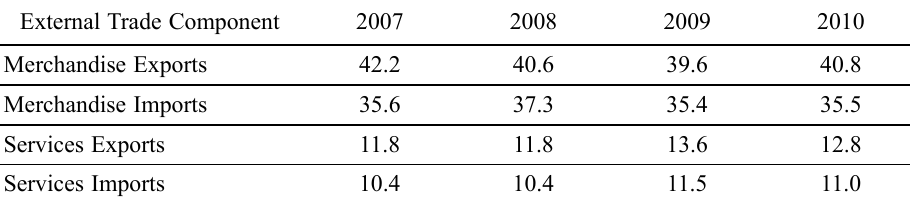
Table 1. Singapore’s external trade components (% share of total trade), 2007–2010